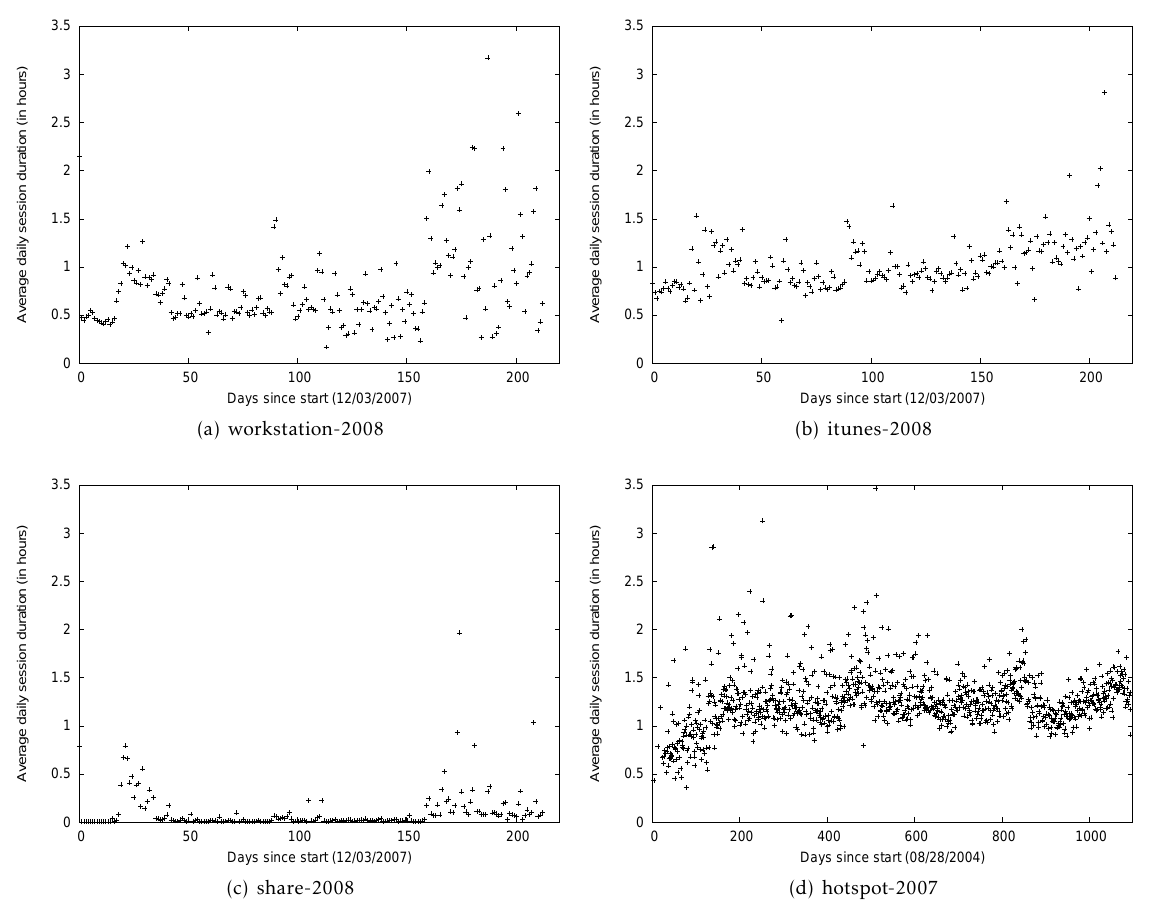
Figure 5. Evolution of session